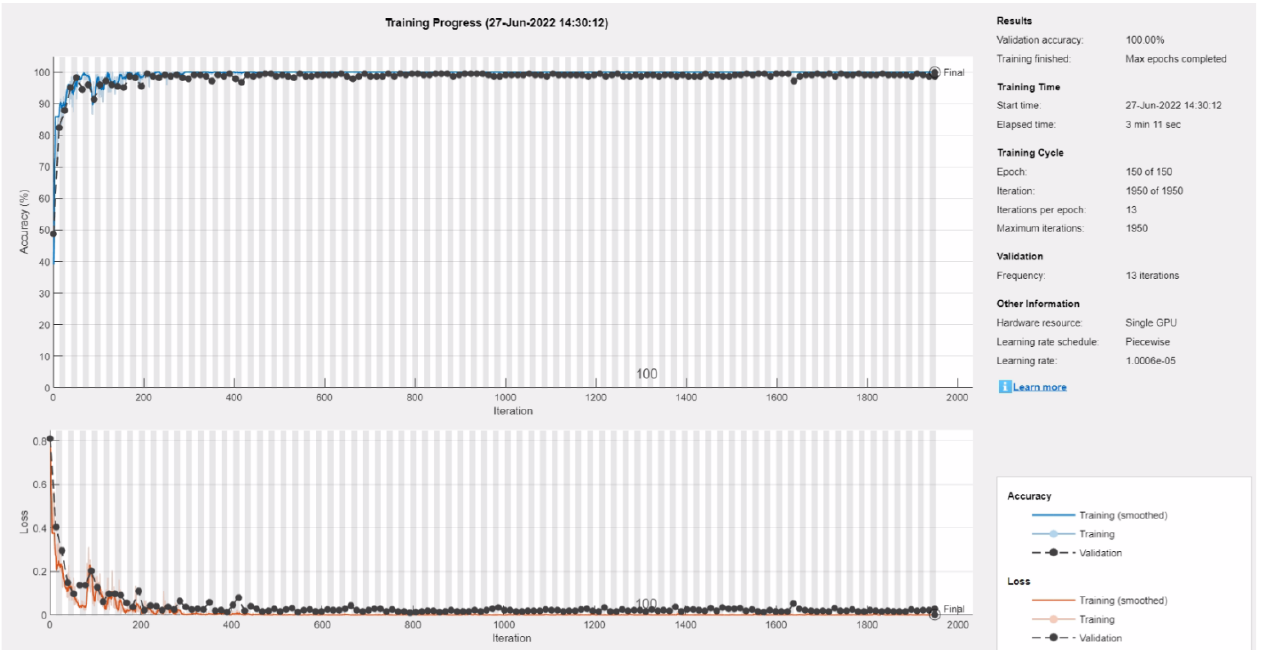
Figure 6. Training progress plot of the optimal proposed CNN model in the 13th optimization iteration. Upper subplot shows the percent accuracy for the training and validation subsets and lower subplot presents the corresponding loss.